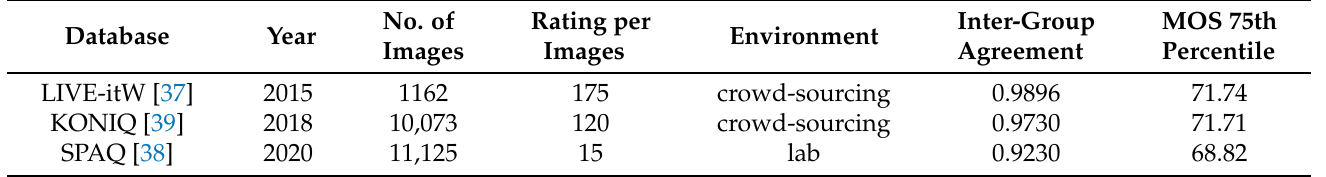
Table 2. Overview of databases used for image quality assessment with real distorted images.